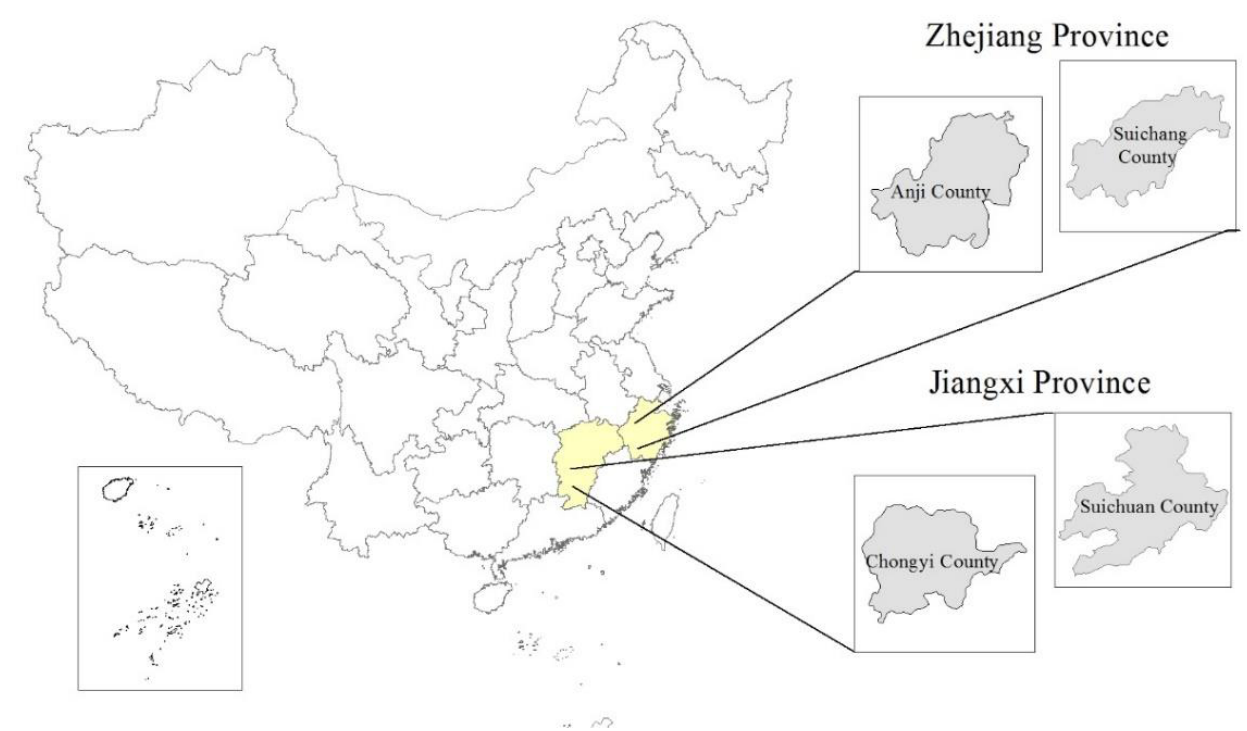
Figure 1. Geographical distribution of sample areas in Southern China.